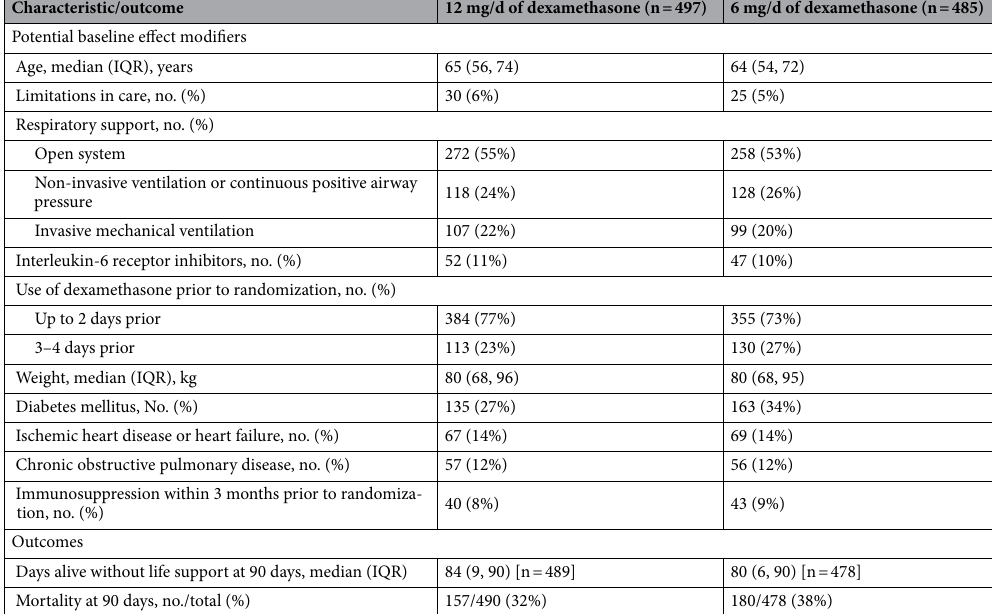
Table 1. Summary statistics for the potential effect modifiers and outcomes by treatment arm. Some of these results were previously reported in Tables 1 and 2 of the primary manuscript for this trial. mg/d, milligrams per